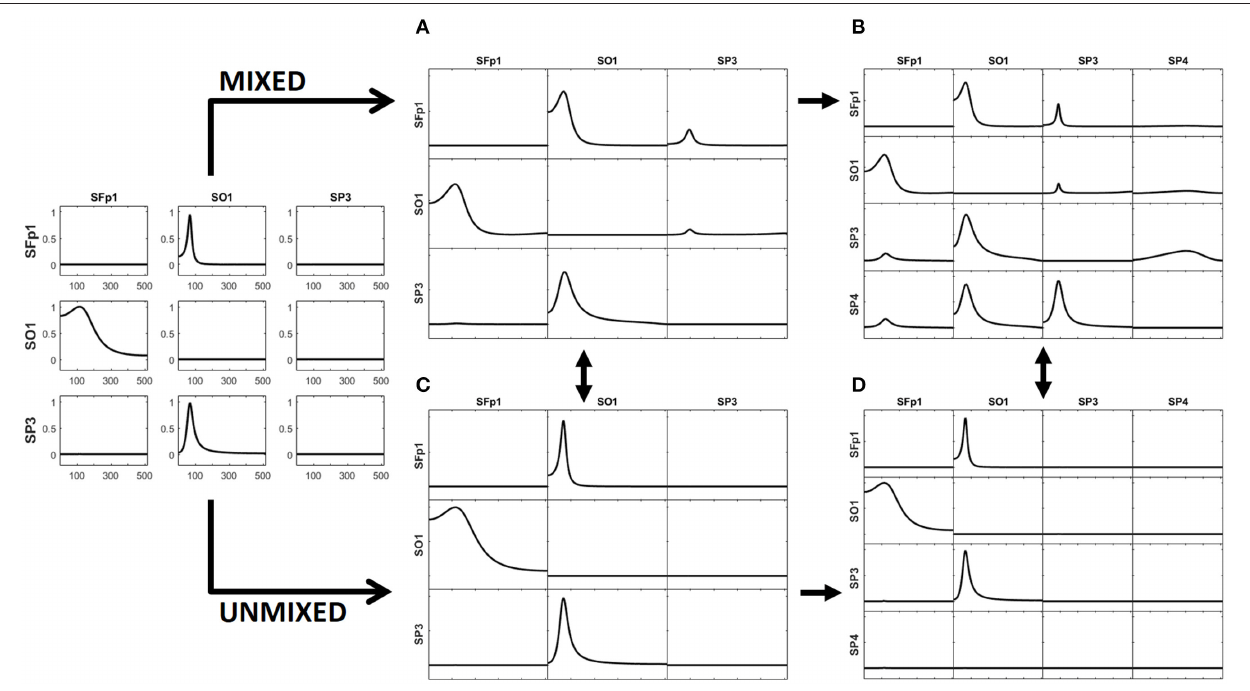
FIGURE 2 | To the left, the iCoh results of connectivity between the original variables used for the simulation. Panel (A) shows the iCoh measures of connectivity based on the (mixed) current estimates by sLoreta at the point sources considered in the simulation. Panel (B) shows that spurious patterns appear when adding in the analysis new voxels that were not originally considered in the simulation of the source. Panels (C,D) show the exact reconstruction of the connectivity patterns achieves by applying the unmixing procedure. Panel (B) for the voxels included in the simulation of the source; panel (D) when adding new voxels not included in the simulation. In both cases, the reconstruction of the original patterns is